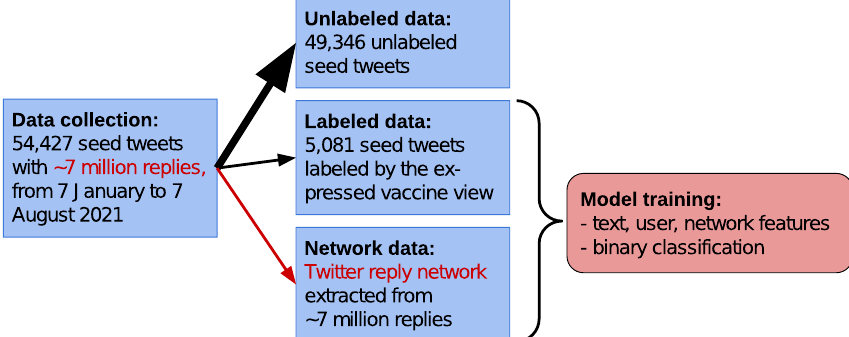
Fig. 1 Overview of our data collection and experiments. In Fig. 10, the binary classification for vaccine skepticism detection is described in more